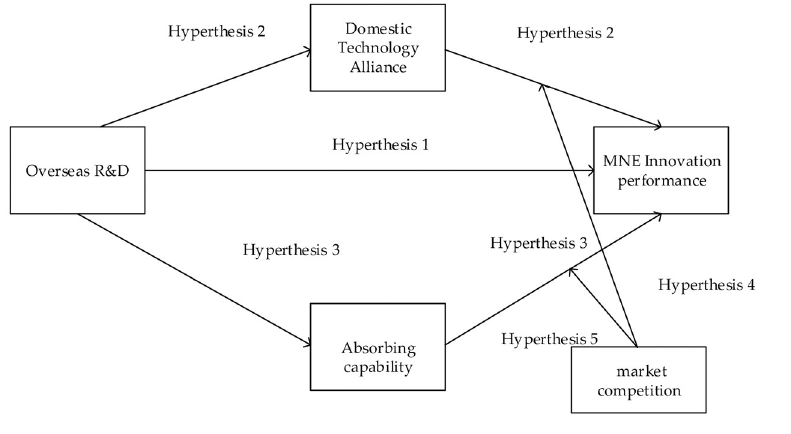
Fig 1. Logic frame